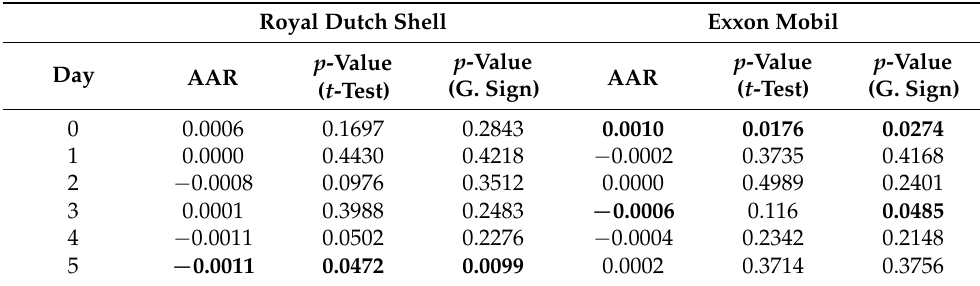
Table 3. Average abnormal returns Royal Dutch Shell and Exxon Mobil—Slochteren induced seismic- ity ( df =